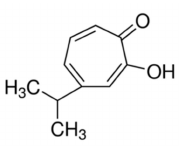
Figure 1. Chemical structure of hinokitiol.